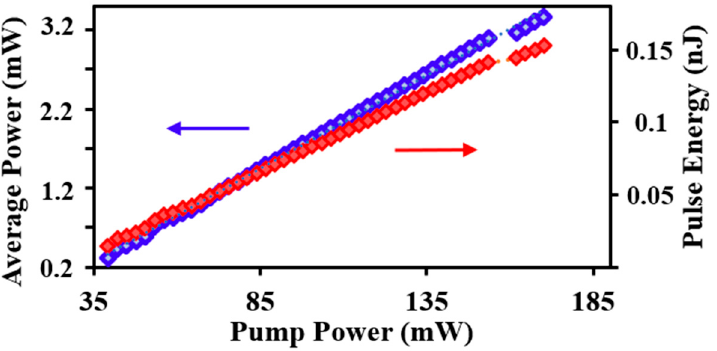
Figure 4. Average output power and pulse energy against pump power for the GO-PEO-based mode-locked soliton EDFL.